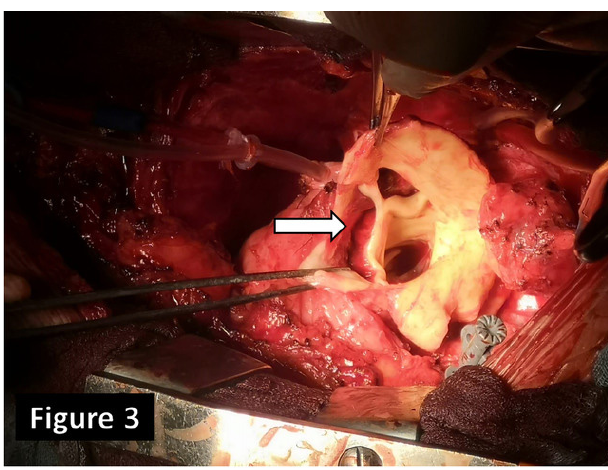
Fig. 3 - Intraoperative picture. Note the extensive intimal flap within the ascending aorta just above the right coronary ostium towards the non-coronary sinus